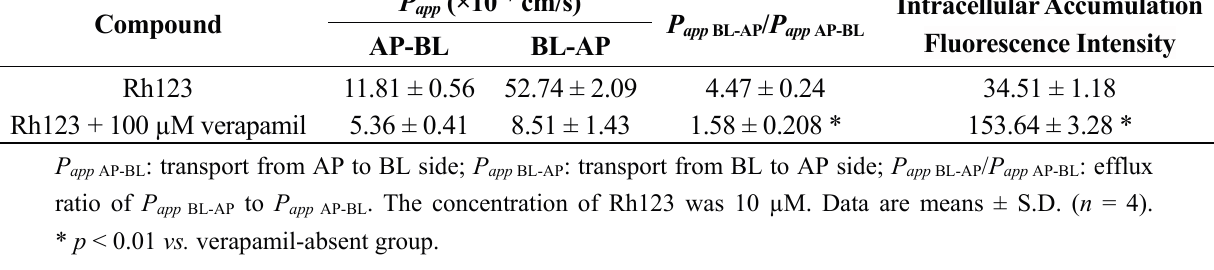
Table 2. Rh123 transportation and intracellular accumulation in MDCK-pHaMDR cell.